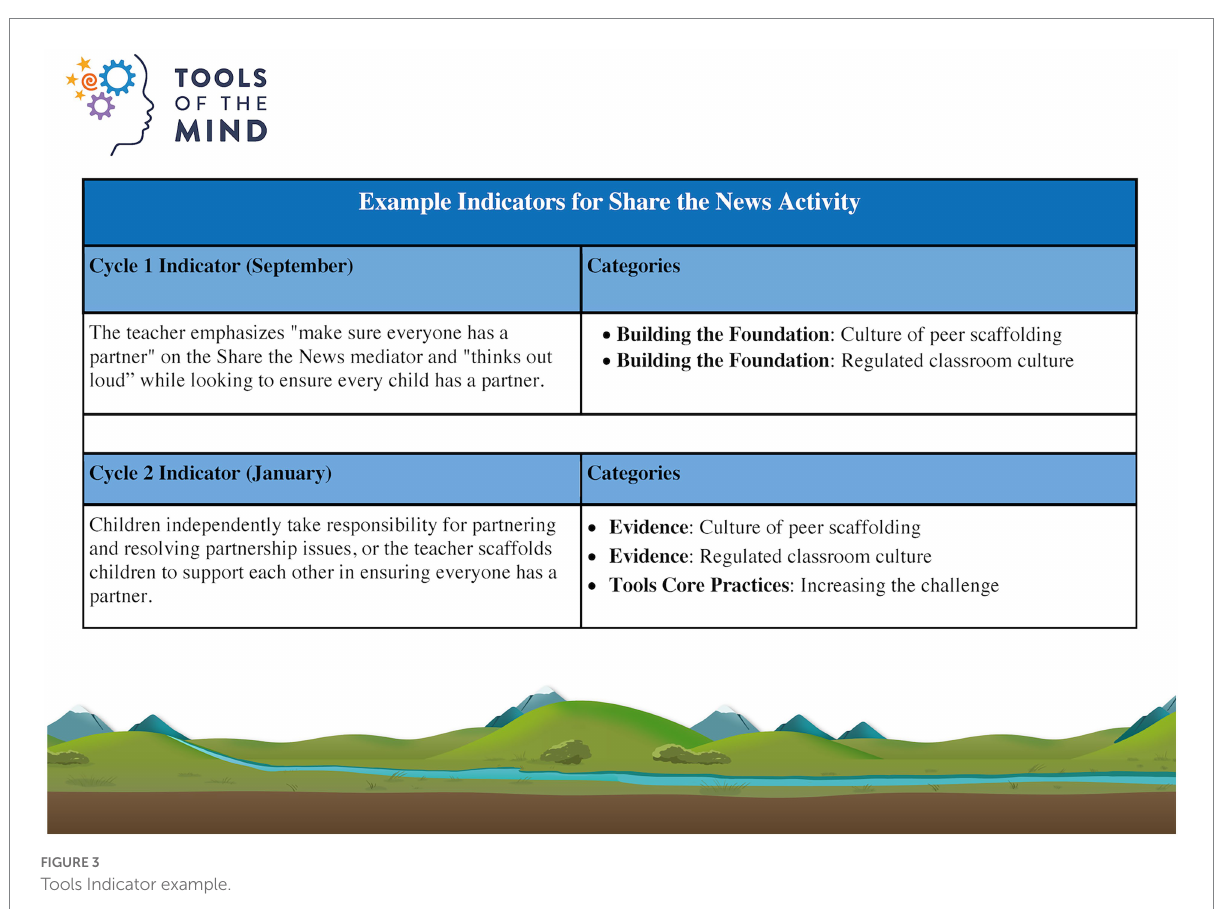
FIGURE 3 Tools Indicator